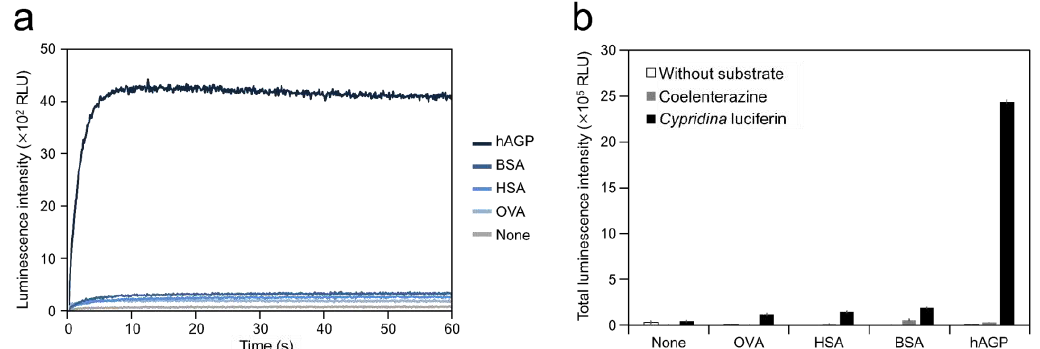
Figure 2. Luminescence of Cypridina luciferin in the presence of human plasma alpha 1-acid glycoprotein (hAGP): ( a ) luminescence kinetics of Cypridina luciferin in the presence of various proteins and ( b ) luminescence intensity of Cypridina luciferin or coelenterazine in the presence of various proteins. None, in the absence of any proteins; OVA, ovalbumin; HSA, human serum albumin; BSA, bovine serum albumin; hAGP, human plasma alpha 1-acid glycoprotein; and CLase, a recombinant Cypridina luciferase from C. noctiluca . The bars represent the mean values ± SD for n = 3. Table 1. Luminescence of Cypridina luciferin in the presence of various proteins. Luminescence Intensity (RLU) Protein Amount of Protein ( µ g) Maximum Intensity Integration over 60 s None 0 192 ± 94 (0.04%) 1 48,651 ± 7566 (0.02%) 1 OVA 2.5 330 ± 79 (0.06%) 1 HSA 2.5 319 ± 12 2.5 hAGP 2.5 4426 ± 23 (0.84%) 1 CLase 0.25 (ng) 524,803 ± 56,087 (100%) 1 297,210,024 ± 31,692,238 (100%) 1 None, in the absence of any proteins; OVA, ovalbumin; HSA, human serum albumin; BSA, bovine serum albumin; hAGP, human plasma alpha 1-acid glycoprotein; CLase, a recombinant Cypridina luciferase from C. noctiluca . Mean ± SD for n = 3. Maximum intensity indicates maximum light intensity over 60 s. 1 Luminescence intensity relative to that of CLase (100% as 0.25 ng of protein used).